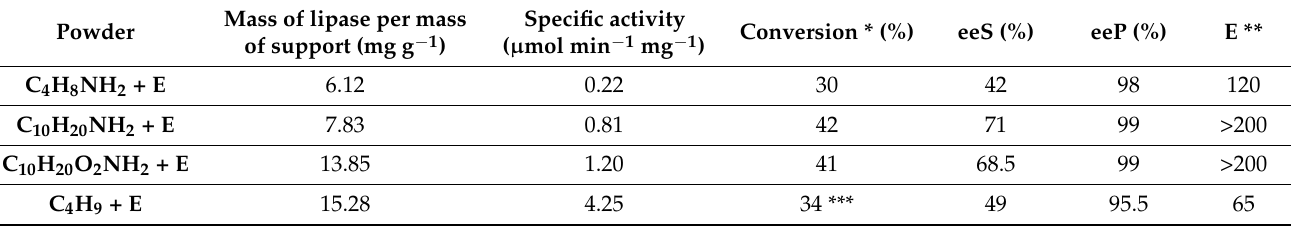
Table 3. Enzyme load and results of transesterification of ( R,S )-1-phenylethanol with vinyl acetate catalyzed by CALB immobilized on modified powders. Enzyme immobilization strategy—covalent bonding—C 4 H 8 NH 2 + E, C 10 H 20 NH 2 + E,